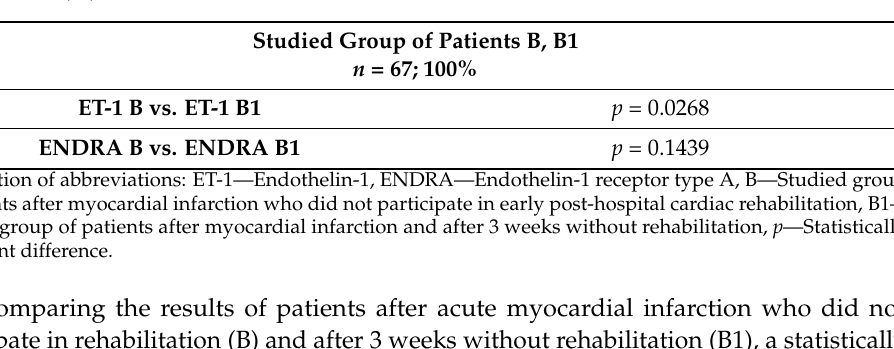
Table 6. Transcriptional activity of the endothelin-1 gene and its A-type receptor among patients after MI who did not participate in early post-hospital cardiac rehabilitation (B) and after 3 weeks without rehabilitation (B’).